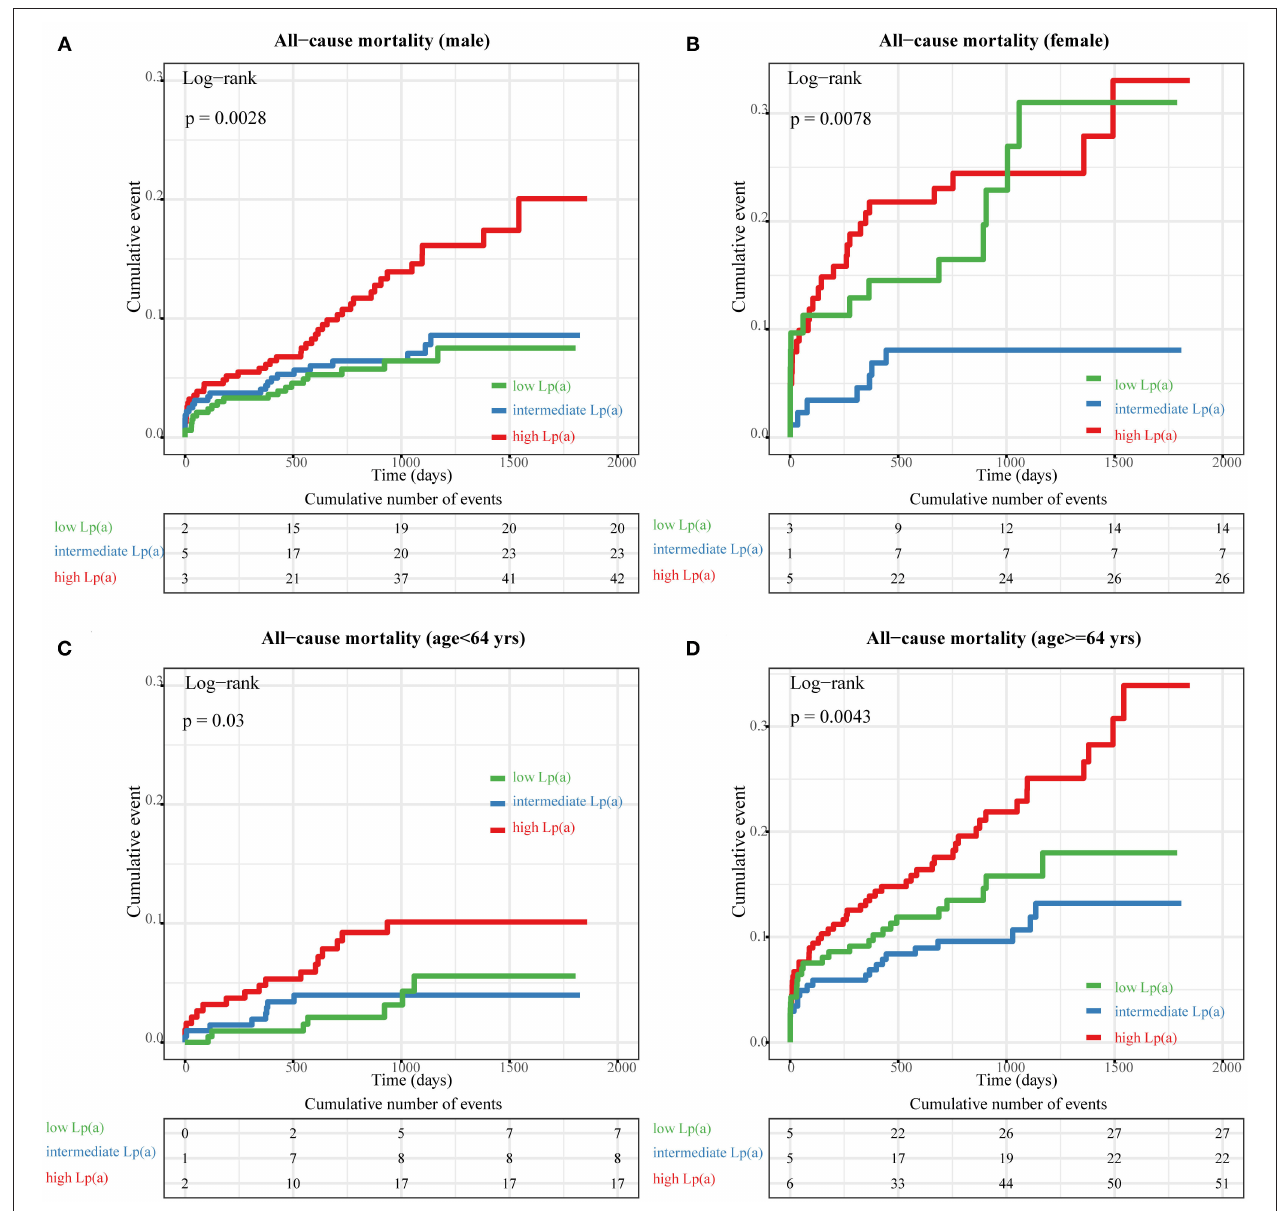
FIGURE 4 | Subgroup analyses of Kaplan–Meier (KM) survival curves according to tertiles of lipoprotein (a) [Lp(a)]. The KM curves of all-cause mortality across different tertiles of Lp(a) in the following groups: (A) male, (B) female, (C) < 64 years old, and (D) ≥ 64 years old.